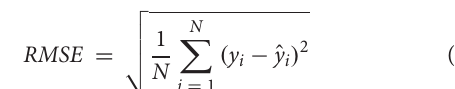
had a collinearity relationship with other indicators.